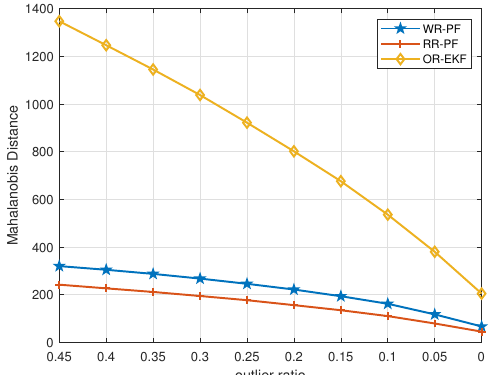
Figure 5. Estimated Mahalanobis distance versus outlier